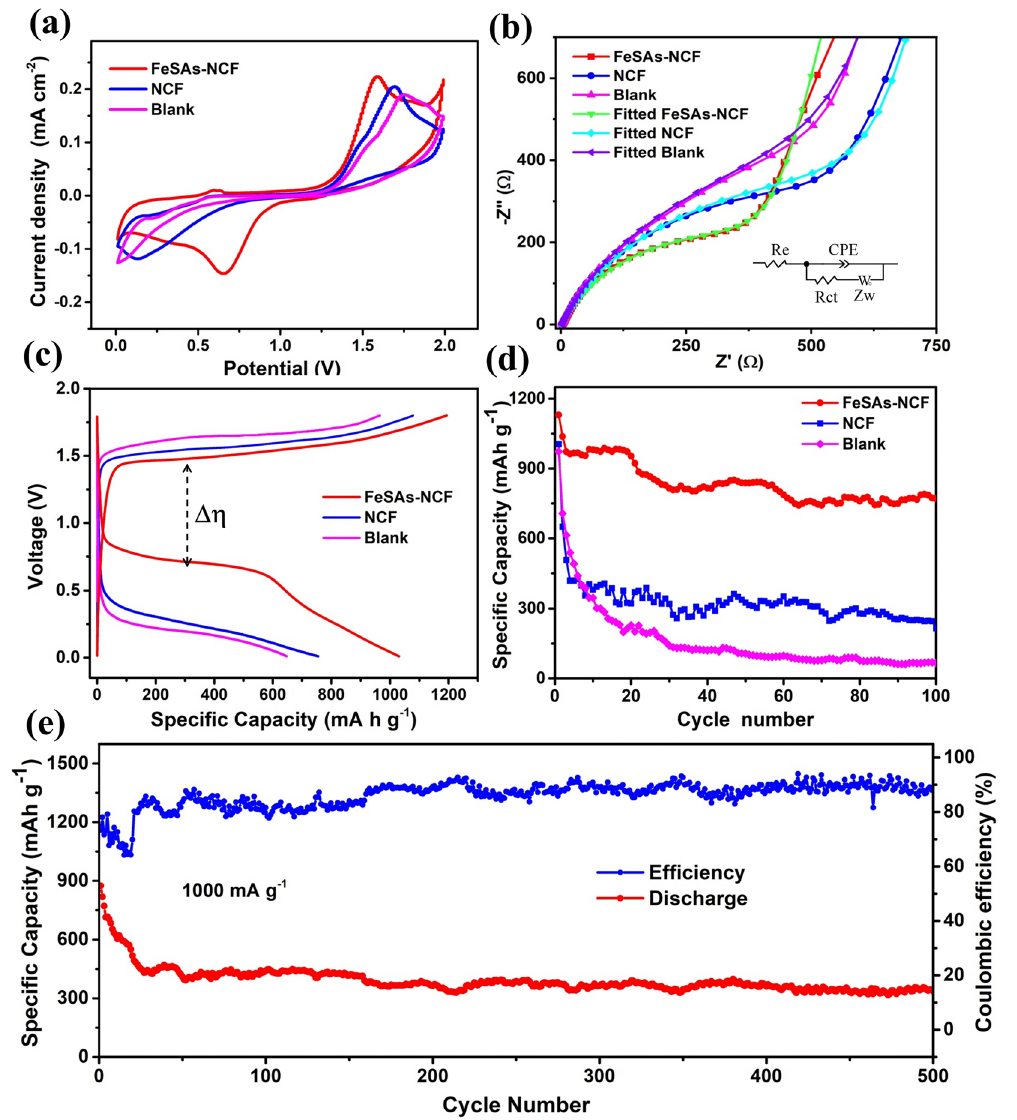
Fig. 3 a CV curves, b Nyquist plots, c charge–discharge curves and d cycling stability of the Al–S batteries with FeSAs-NCF and NCF, and the blank cell, e cycling stability of the cell with FeSAs-NCF at 1000 mA g.